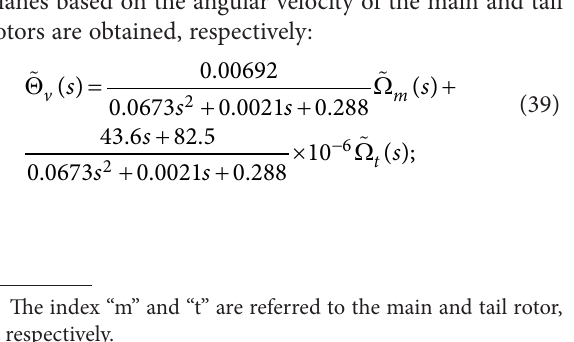
Figure 6. Motors